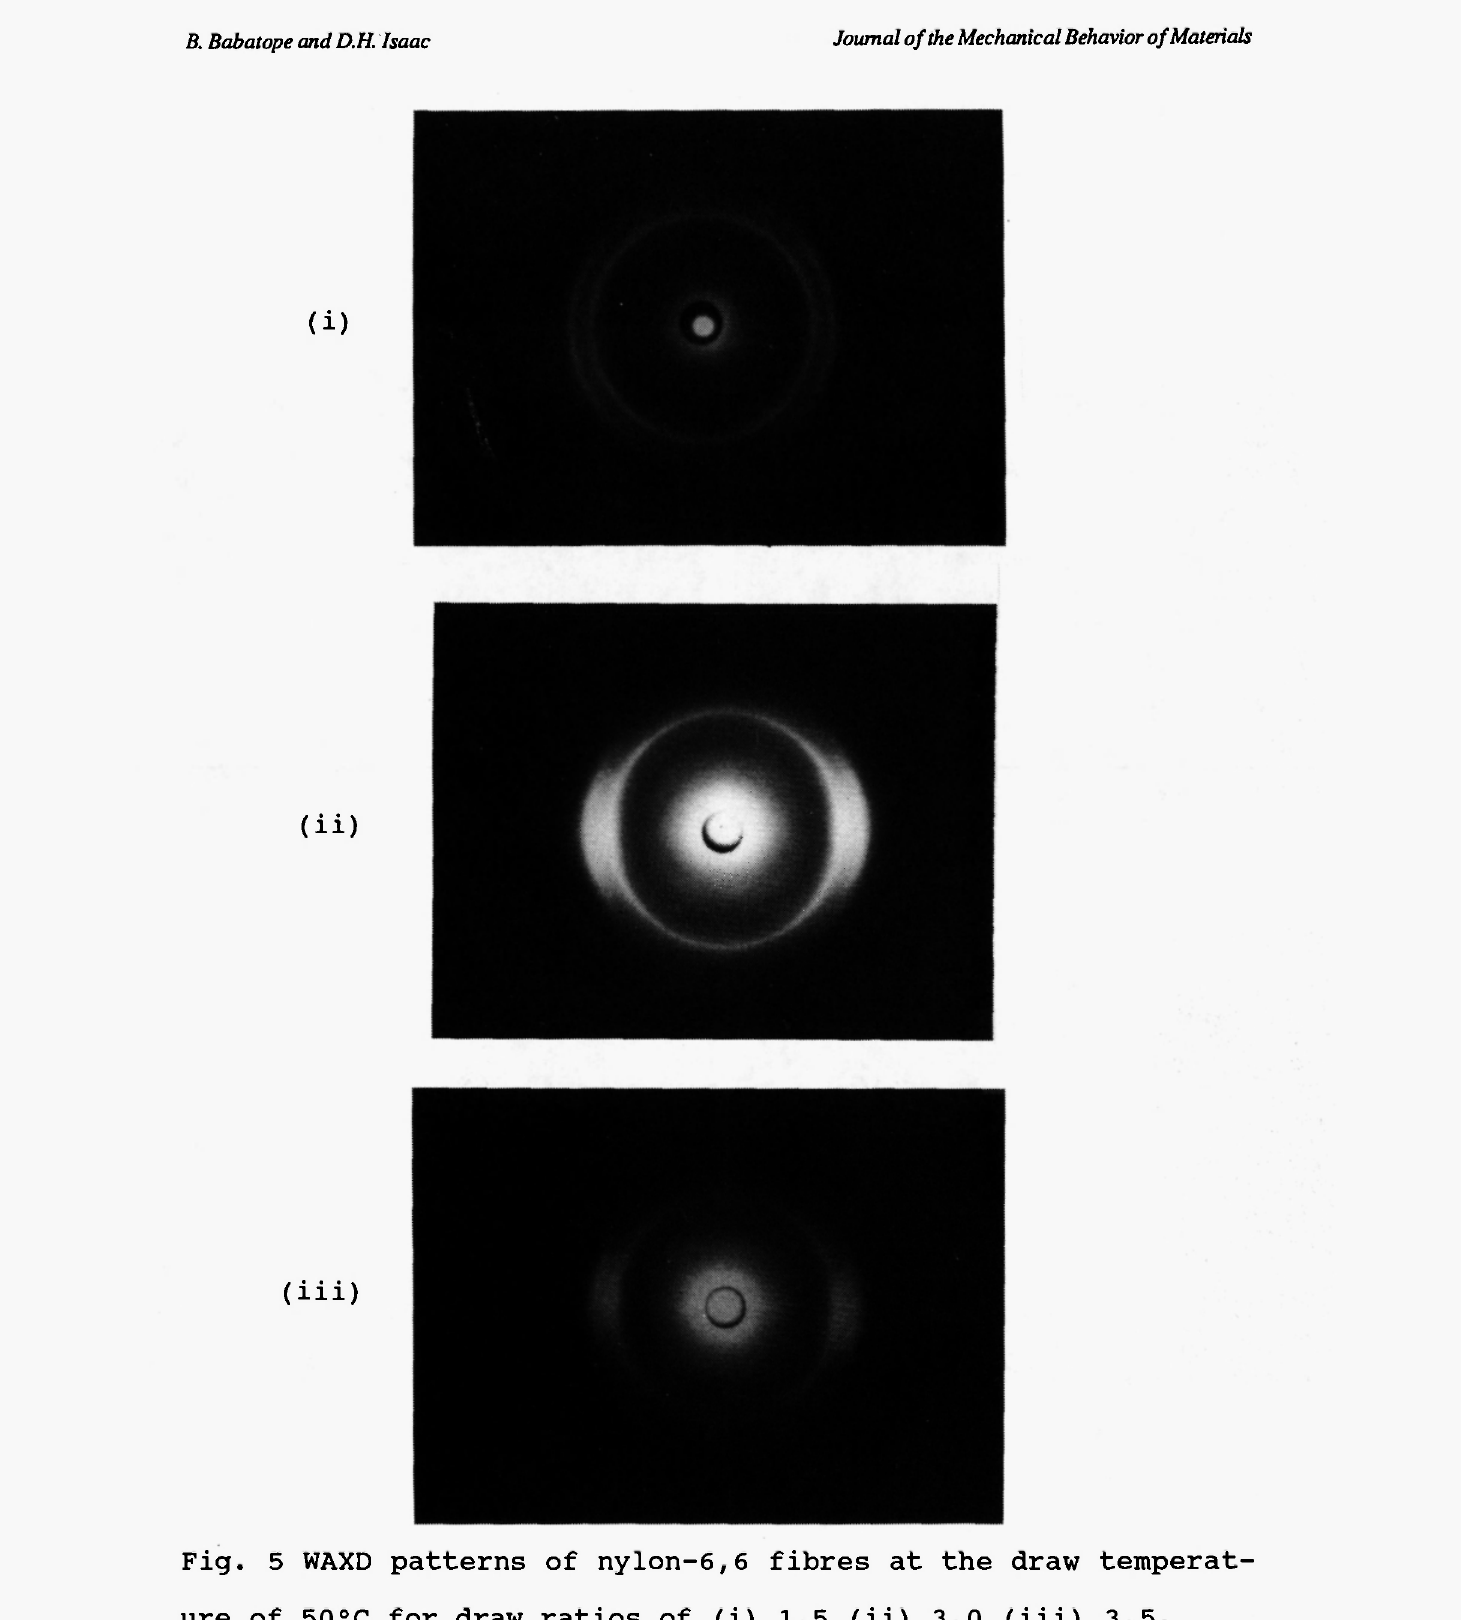
Fig. 5 WAXD patterns of nylon-6,6 fibres at the draw temperat- ure of 50°C for draw ratios of (i) 1.5 (ii) 3.0 (iii)